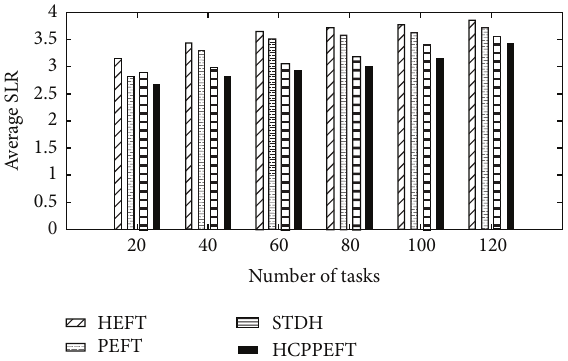
Figure 4: Average SLR with CCR = 2 for random task graphs.